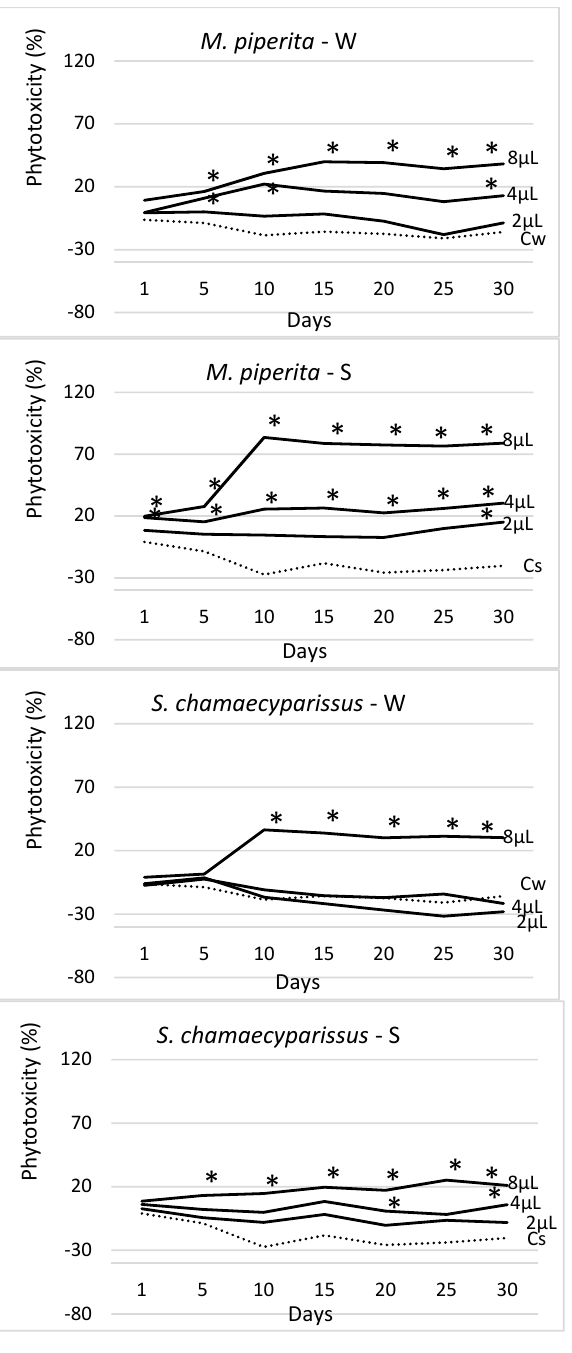
Figure 4. Trend over time of the phytotoxicity level (%) of 4 EOs at three doses (2 µL, 4 µL, 8 µL), distributed by watering (W) and spraying (S) on seedlings of Erigeron bonariensis . For each observation day, values marked with * are significantly different from the respective water controls (Cw and Cs; dotted lines) (Dunnett’s test, P ≤ 0.05).